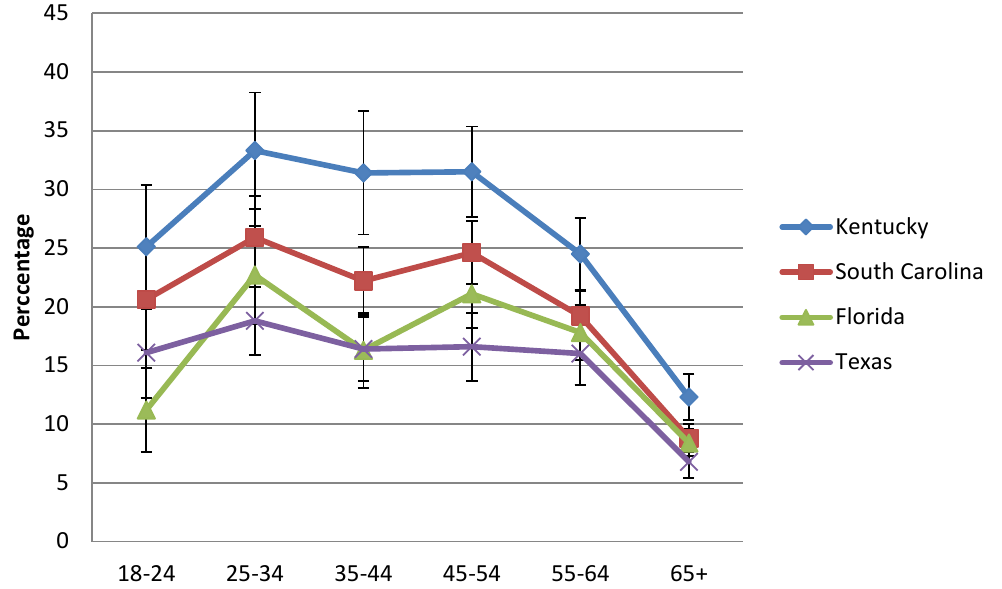
Figure 2. Current smoking rates based on age group (years) for FL, KY, SC, and TX using the 2015 Behavioral Risk Factor Surveillance System health survey.